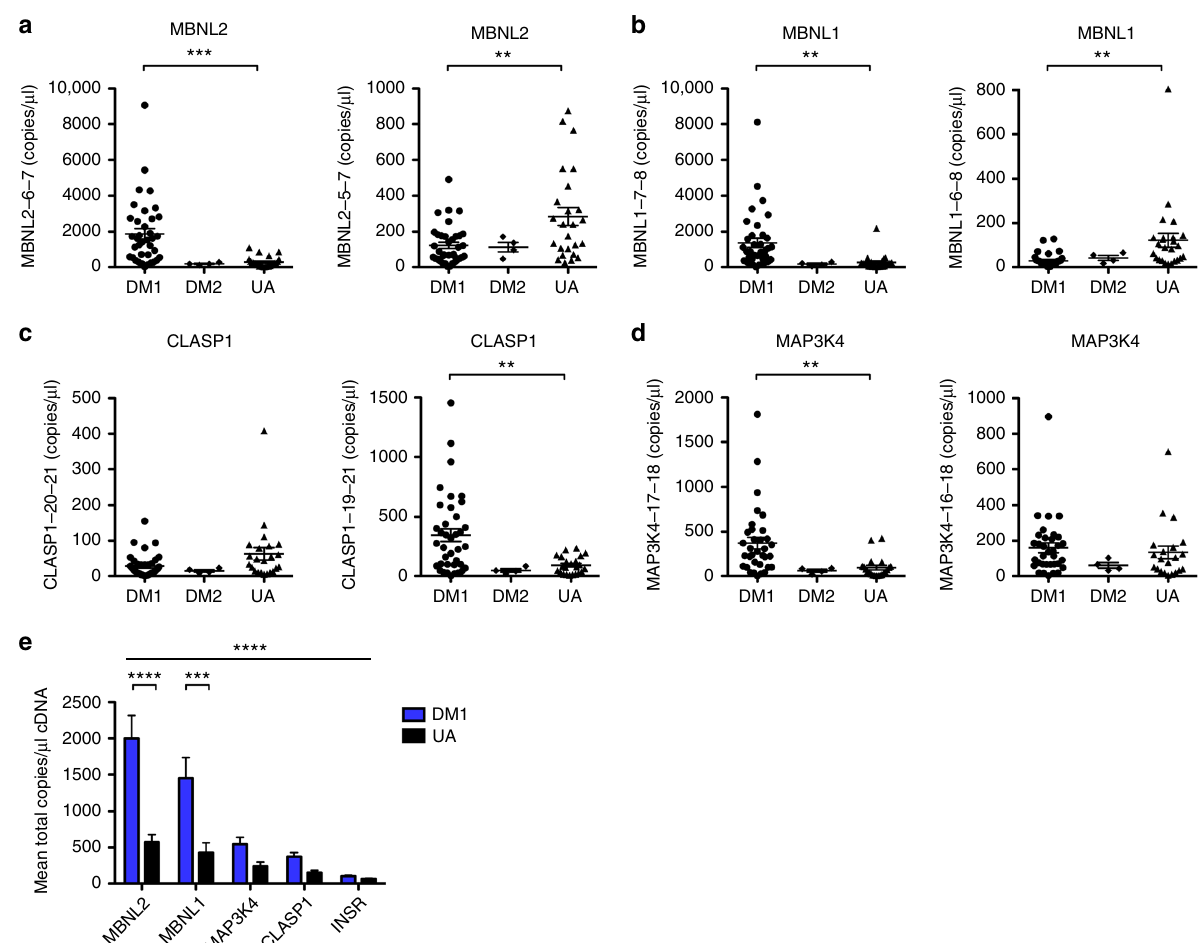
Fig. 6 Droplet digital PCR (ddPCR) analysis of alternative splicing in human urine exRNA. We used ddPCR to examine alternative splicing of MBNL2 exon 6, MBNL1 exon 7, CLASP1 exon 20, and MAP3K4 exon 17 in urine exRNA samples from DM1 ( N = 34 – 37), DM2 ( N = 4), and UA controls ( N = 24 or 25). Individual data points represent the mean of duplicate assays for each sample. a Quanti fi cation of MBNL2 splice products that include (MBNL2-6-7; left) and exclude exon 6 (MBNL2-5-7; right) in urine exRNA as transcript copies/ μ l cDNA. Error bars indicate mean ± s.e.m. **** P < 0.0001 (exon 6 inclusion, DM1 vs. UA); ** P = 0.005 (exon 6 exclusion, DM1 vs. UA); one-way ANOVA. b Quanti fi cation of MBNL1 splice products that include (MBNL1-7-8; left) and exclude exon 7 (MBNL1-6-8; right) in urine exRNA as transcript copies/ μ l cDNA. Error bars indicate mean ± s.e.m. ** P = 0.003 (exon 7 inclusion, DM1 vs. UA), and P = 0.005 (exon 7 exclusion, DM1 vs. UA); one-way ANOVA. c Quanti fi cation of CLASP1 splice products that include (CLASP1-20-21; left) and exclude exon 20 (CLASP1-19-21; right) in urine exRNA as transcript copies/ μ l cDNA. Error bars indicate mean ± s.e.m. *** P = 0.0009 (exon 20 exclusion, DM1 vs. UA); one-way ANOVA. d Quanti fi cation of MAP3K4 splice products that include (MAP3K4-17-18; left) and exclude exon 17 (MAP3K4-16-18; right) in urine exRNA as transcript copies/ μ l cDNA. Error bars indicate mean ± s.e.m. ** P = 0.0025 (exon 17 inclusion, DM1 vs. UA); one-way ANOVA. e Mean total copies/ μ l cDNA (exon inclusion + exclusion values from a to d and Fig. 5) for each transcript in urine exRNA. Error bars indicate mean ±